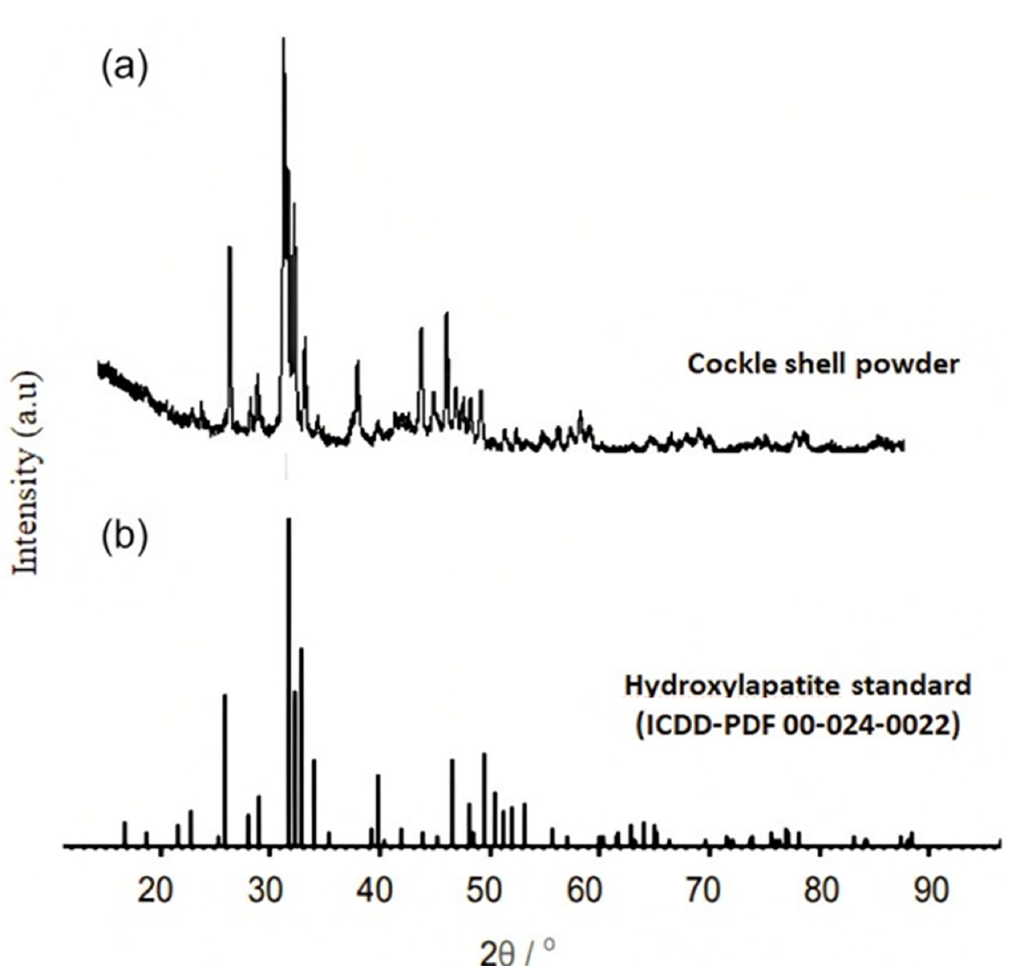
Figure 3. XRD diffractograms for the ( a ) cockle shell powder ( b ) standard of